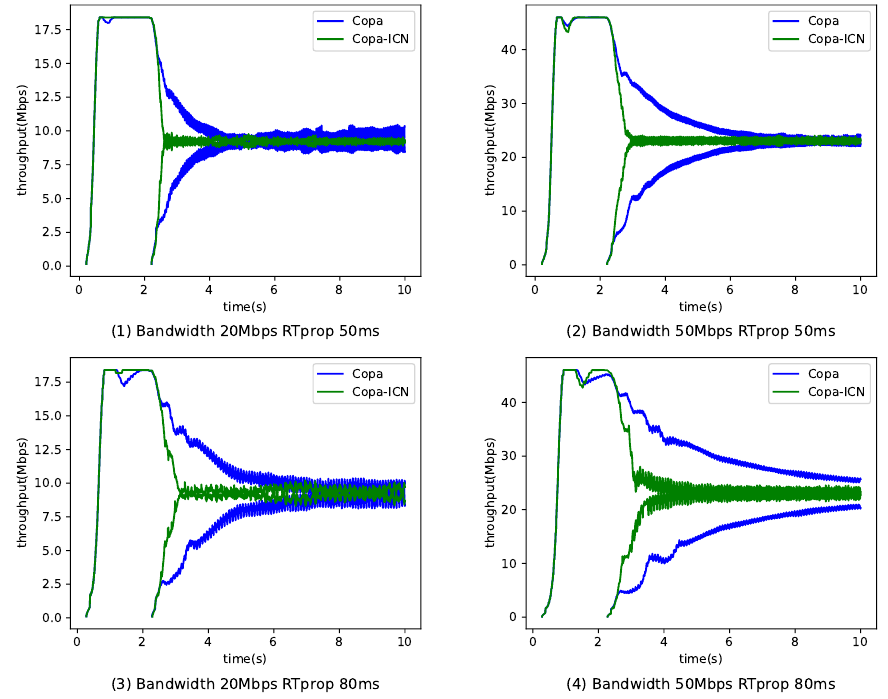
Figure 9. Convergence of the two transmission processes for different bandwidths and